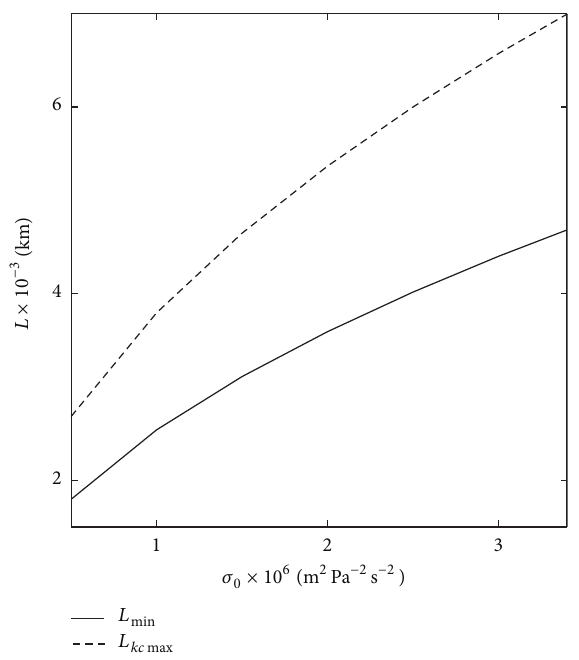
Figure 2: Length of waves with maximum growth rates 𝐿 𝑘𝑐 max and short-wave cutoff 𝐿 min , as functions of the static stability parameter 𝜎 0